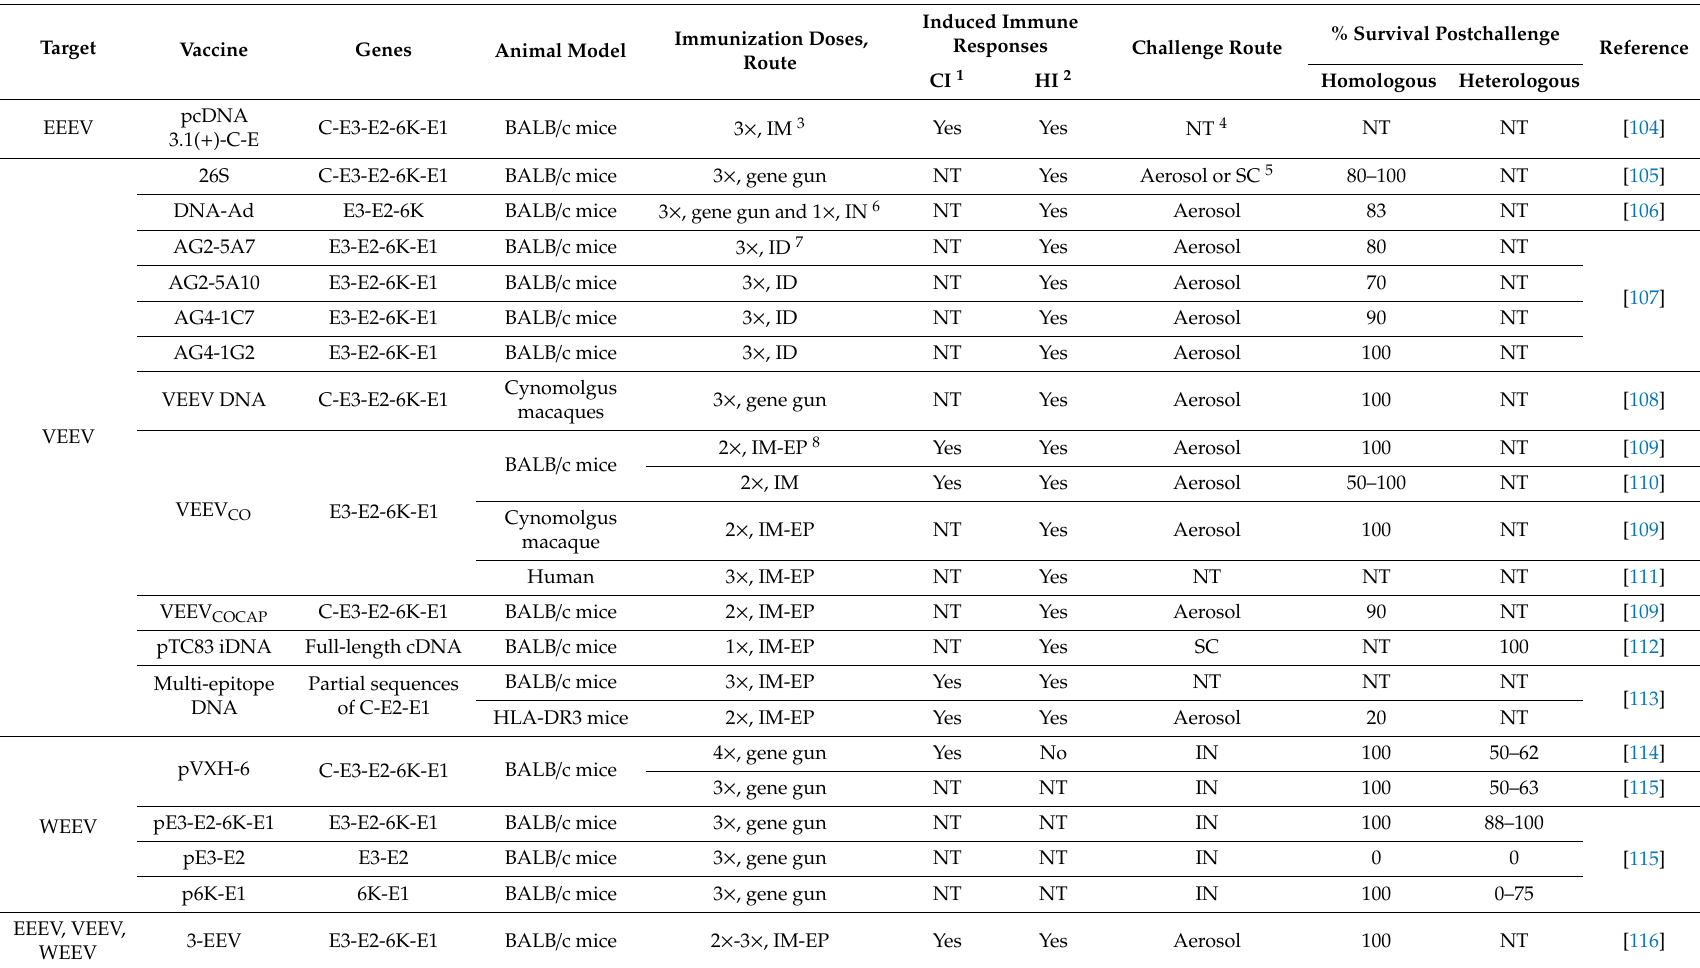
Table 2. Summary of recent plasmid DNA vaccine candidates for Eastern, Venezuelan, and Western equine encephalitis